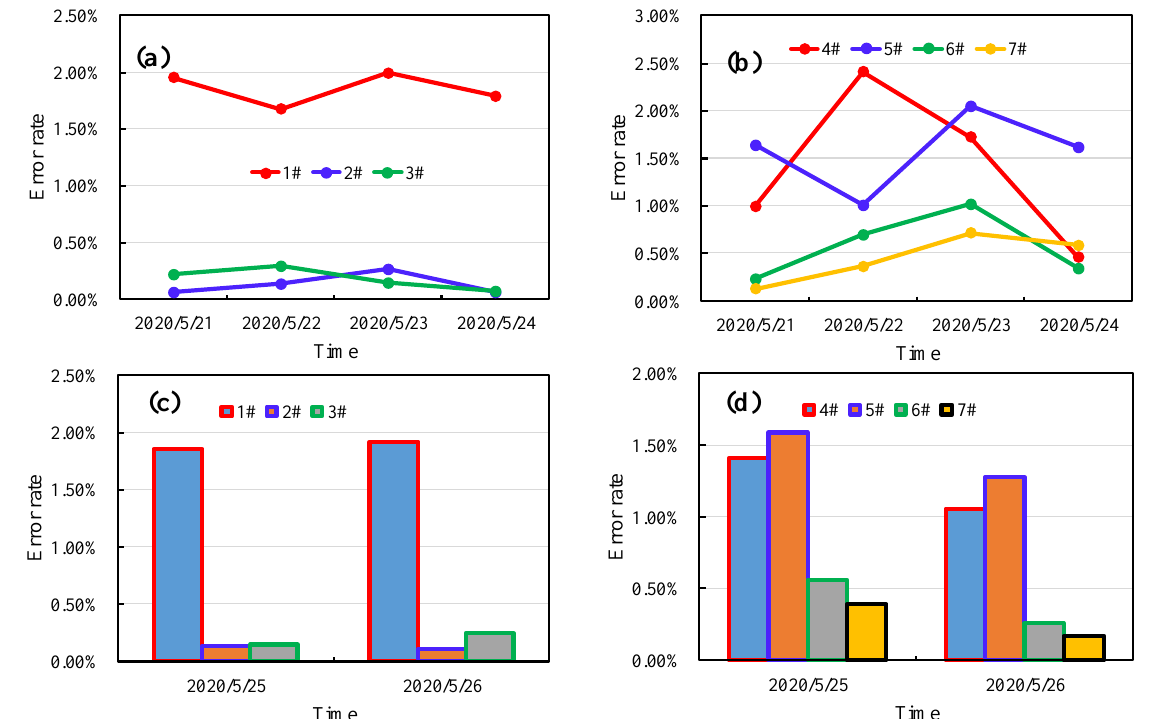
Figure 8. Relative error of the grey prediction method: ( a , c ) represents the coal mining face; ( b , d ) stands for the intake and return air roadways of the working face.